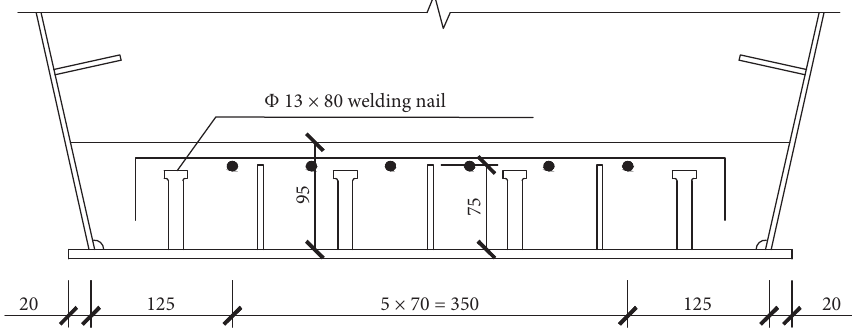
Figure 4: Concrete structure of base plate (unit: mm).